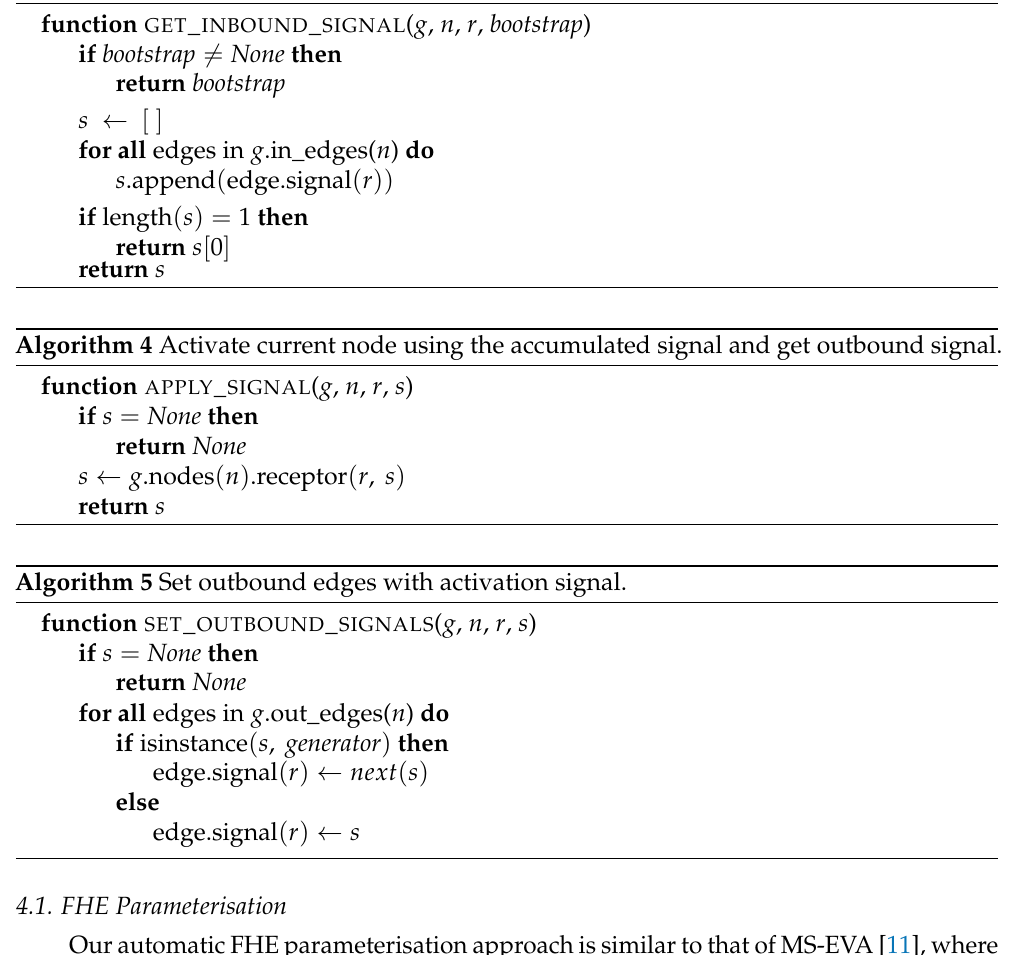
Algorithm 3 Calculate accumulated inbound signal from edges.